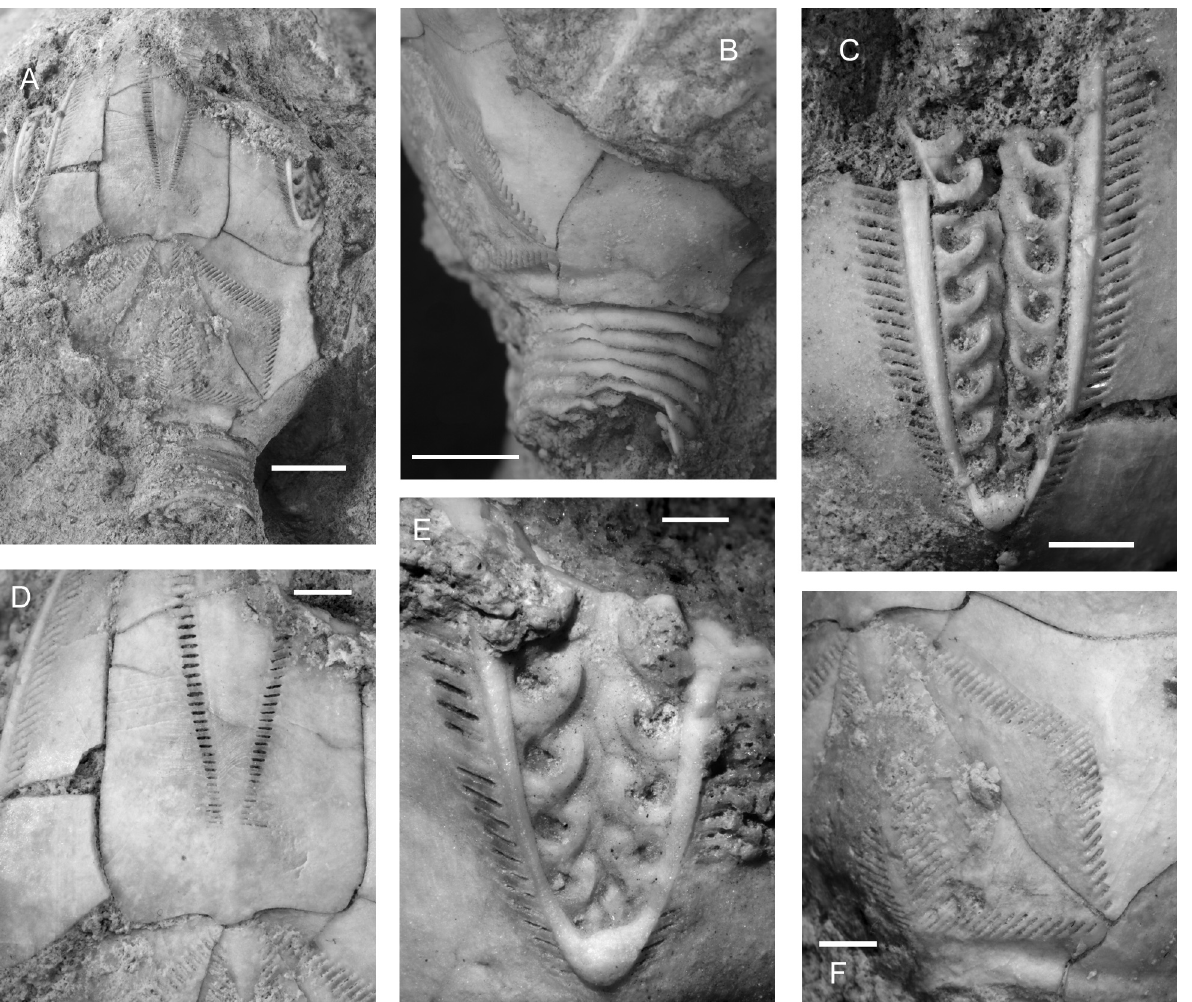
Fig. 2. Photographs of Cystoblastus kokeni Jaekel, TUG 1727­548, Kukruse Regional Stage (Viivikonna Formation), Kohtla, Estonia. A , general view of partial theca showing anterior view. B , close up of the proximal stem showing overlapping flanges of outer columnals. C , detail of ambulacrum E showing the main food groove with zigzag suture between floor plates and lateral food grooves ending in circular facets. Note the thick ambulacral rim, swelling at the tip and relatively long and thin slits for the pectinirhombs. D , detail of base of plate R2 and its suture with IL2, B2 and IL1 (from left to right). Note the base of plate R2 is sinuous and symmetrical and the lowest pectinirhomb slit on the right extends towards the right suture. E , detail of the tip of ambulacrum D showing the plate sutures, ambulacral rim with terminal swelling and pectinirhomb slits. F , detail of basal pectinirhomb B2:IL1. Note the slits in B2 (lower left) are narrower and longer than those in IL1 (upper right). Scale bars = 5 mm ( A , B ), 3 mm ( C ) and 2 mm ( D – F